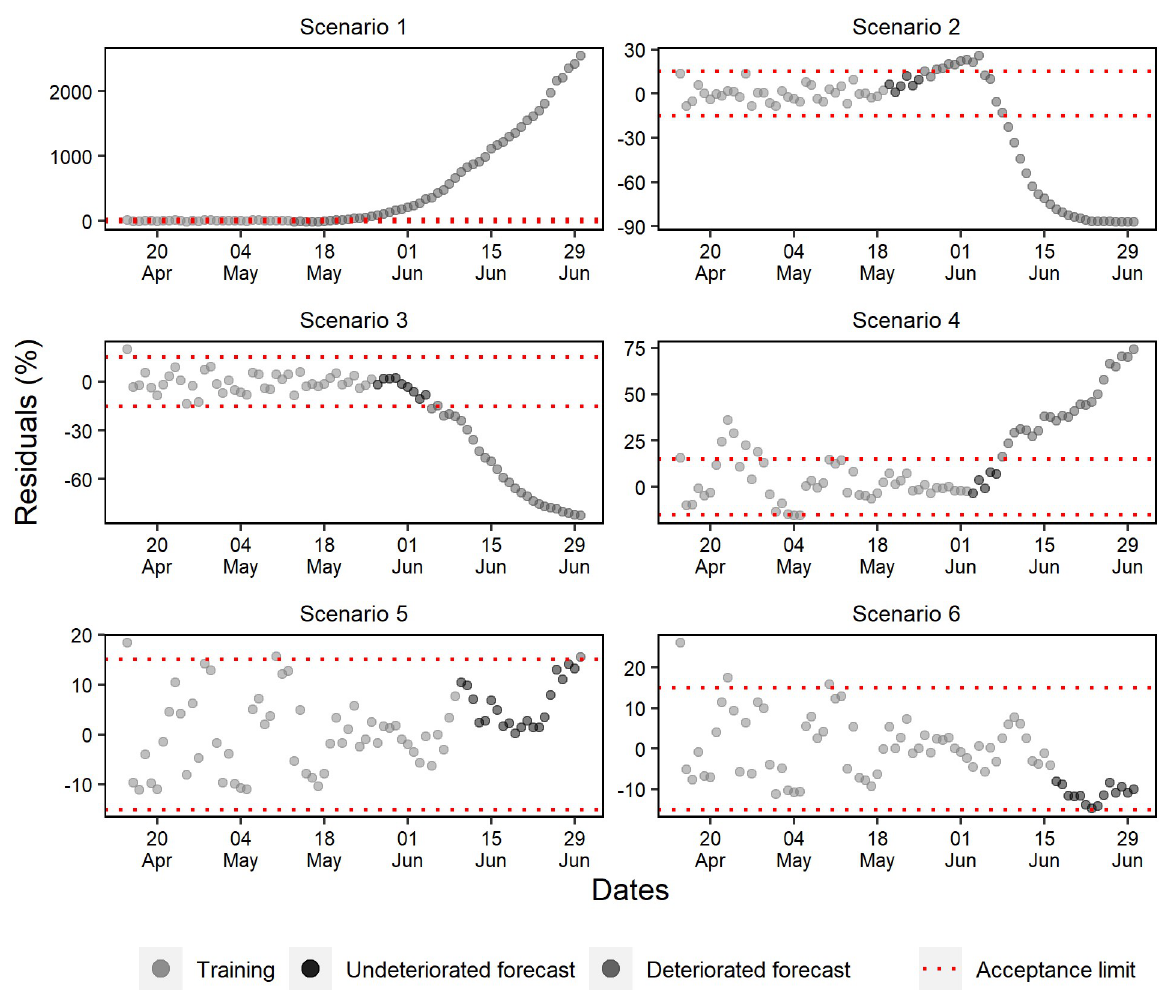
Fig 15. Percentual residuals for ICU bed occupancy in the 6 analyzed